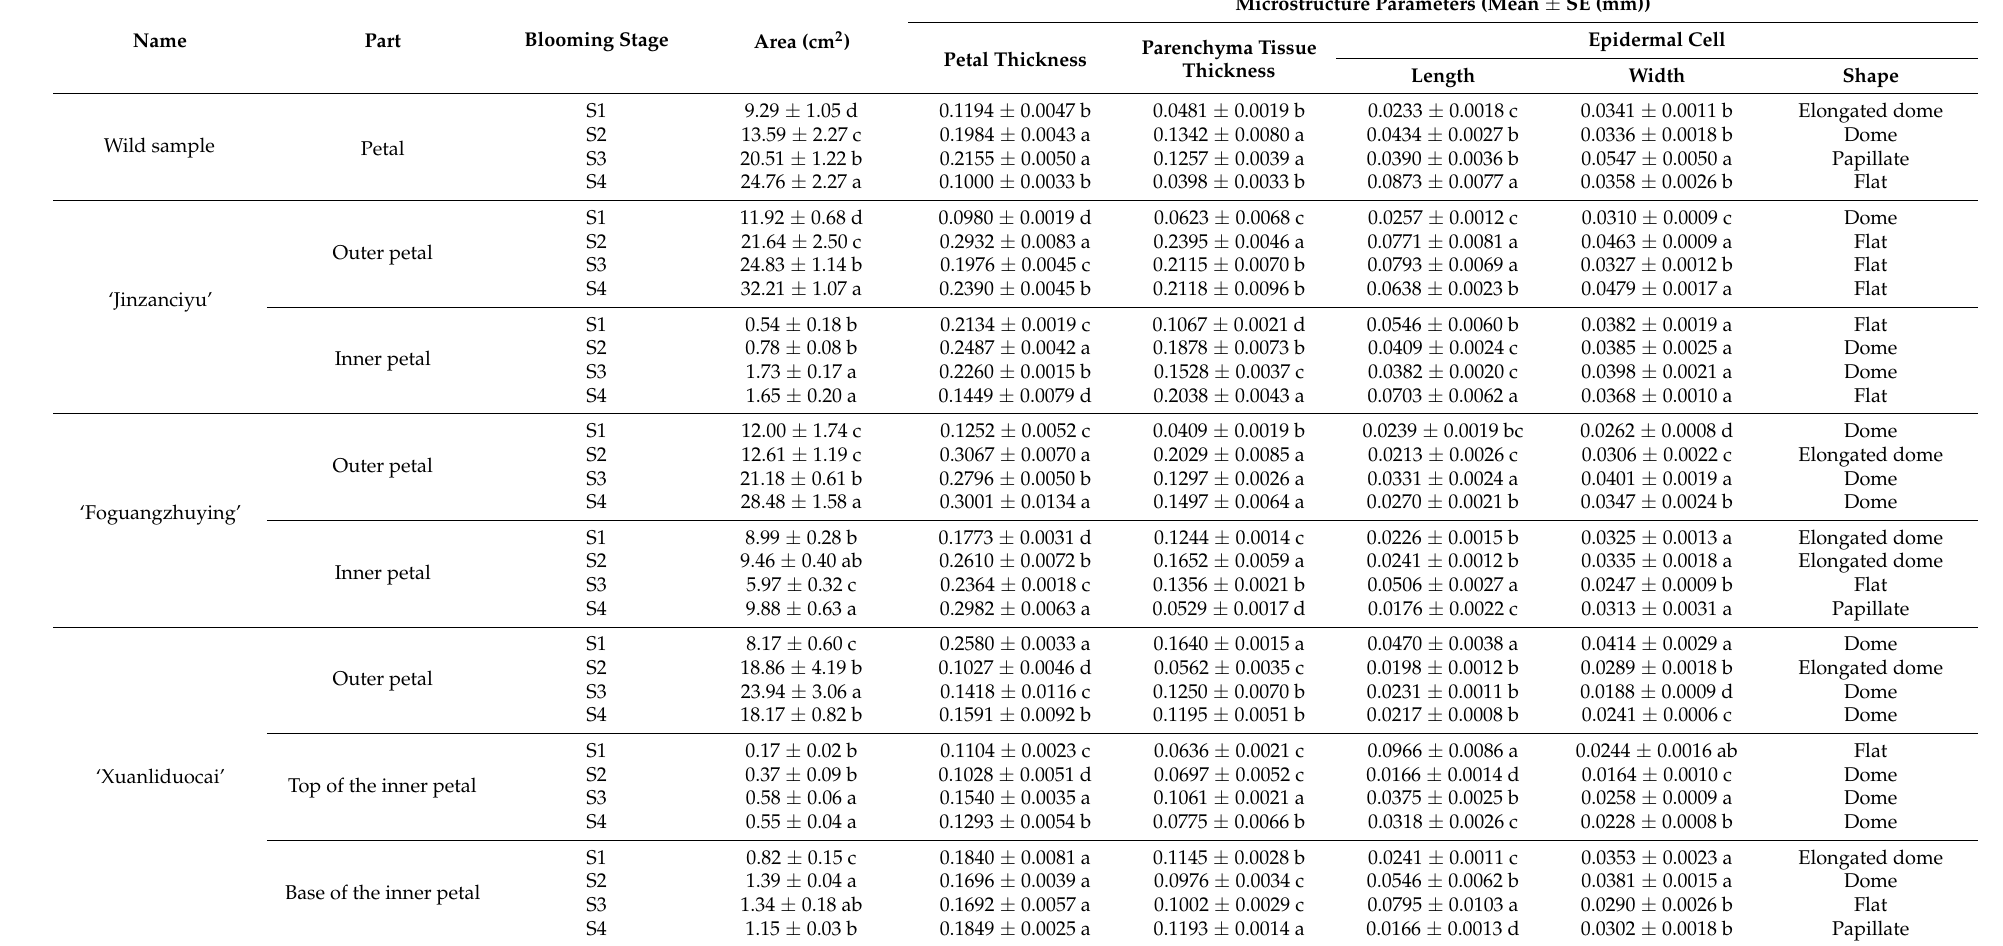
Table 4. Physical parameters of herbaceous peony